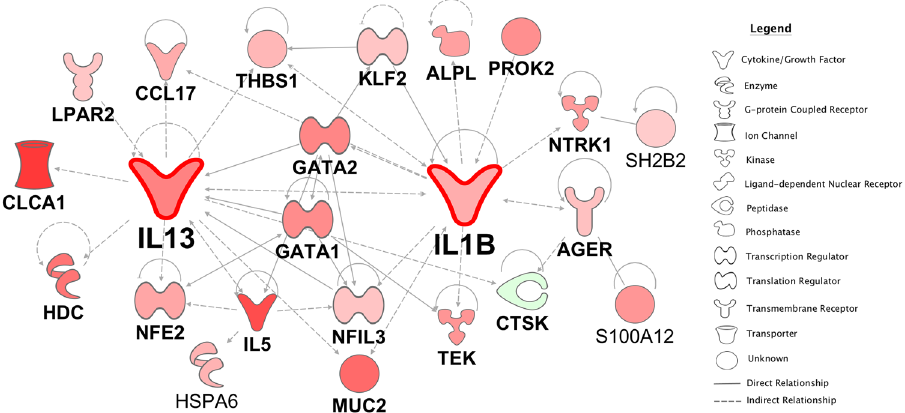
Figure 1. Differential gene network comparing HDM S nonwheezers versus nonatopic controls. Differentially expressed genes were identified with an edgeR analysis. Gene expression patterns in sputum were compared between HDM S nonwheezers and nonatopic controls. The wiring diagram of the underlying gene network was reconstructed employing prior knowledge from the literature (Ingenuity Knowledge Base). Genes highlighted in red denote upregulation, whilst green indicates downregulation in HDM S